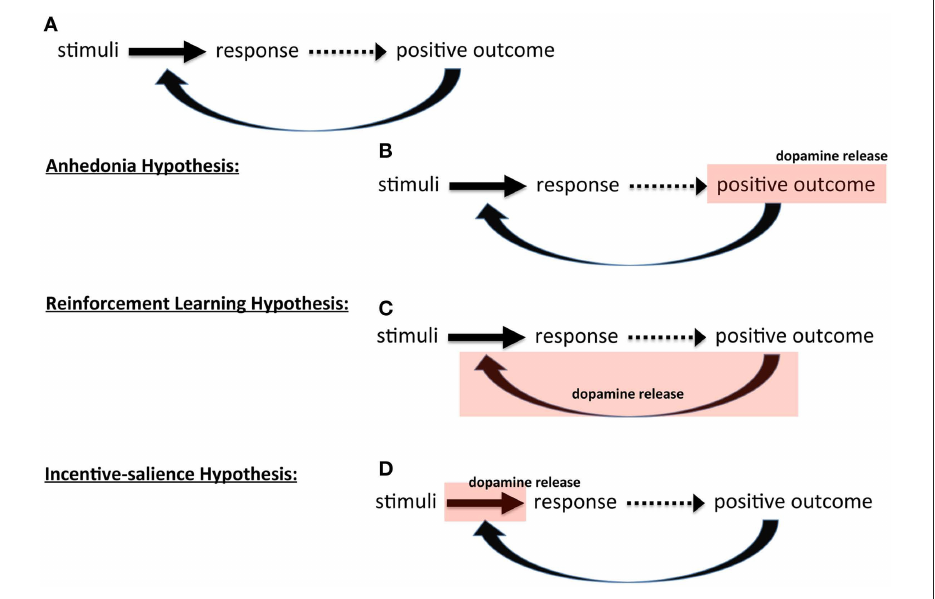
Figure 1 | Theories of dopamine and instrumental behavior. Schematic showing (A) basic outline of instrumental, stimulus-response learning three hypothesis on the role of dopamine: (B) anhedonia hypothesis, (C) reinforcement learning hypothesis, and (D) incentive-salience